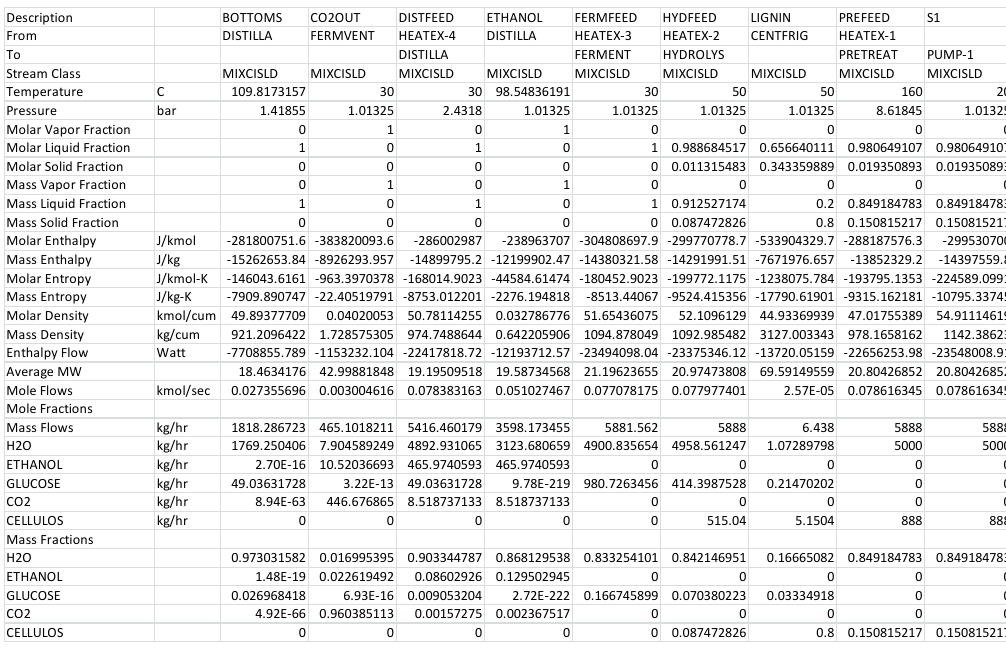
Figure A17. Fermentation stream results (part 1).